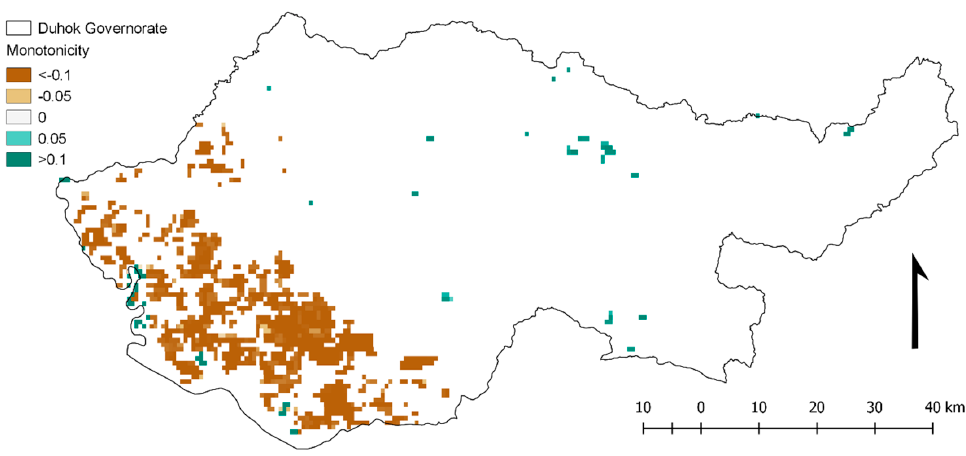
Figure 6. Monotonicity of net photosynthesis in areas with significant trend ( p < 0.05). Positive values indicate that the proportion of increases over time are higher relative to decreases. Higher values in either direction signify increasing (+) or decreasing ( − ) monotonicity.